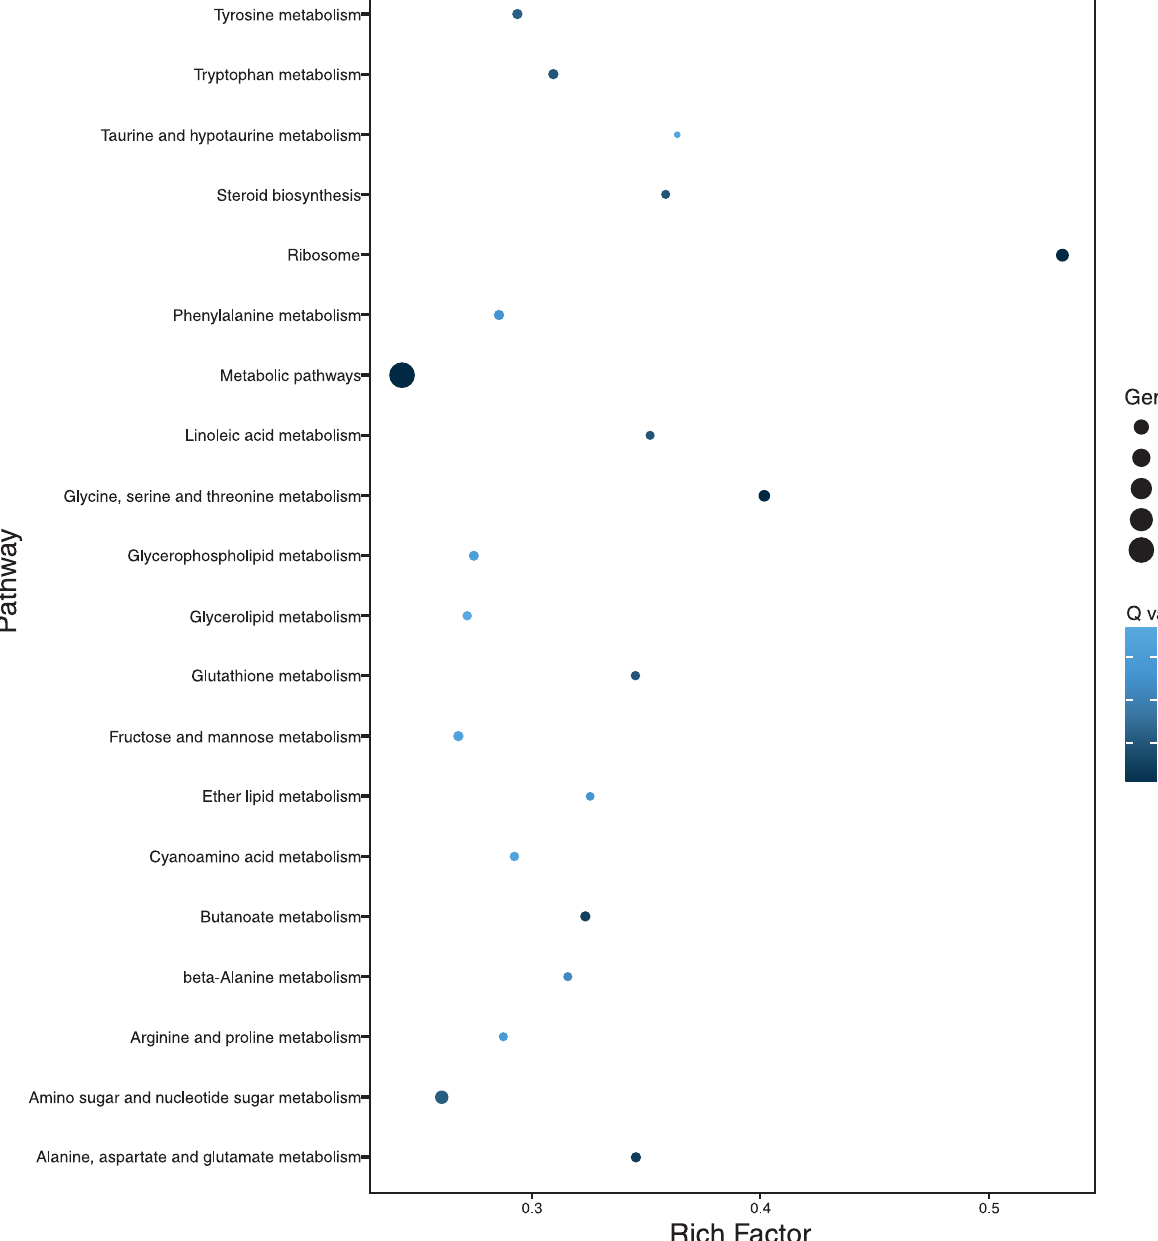
transmembrane transport (Log2FC: up-regulation = 1.59 to 7.04, down-regulation = -1.08) were both up-regulated and down-regulated although proteins of the hydrogen ion